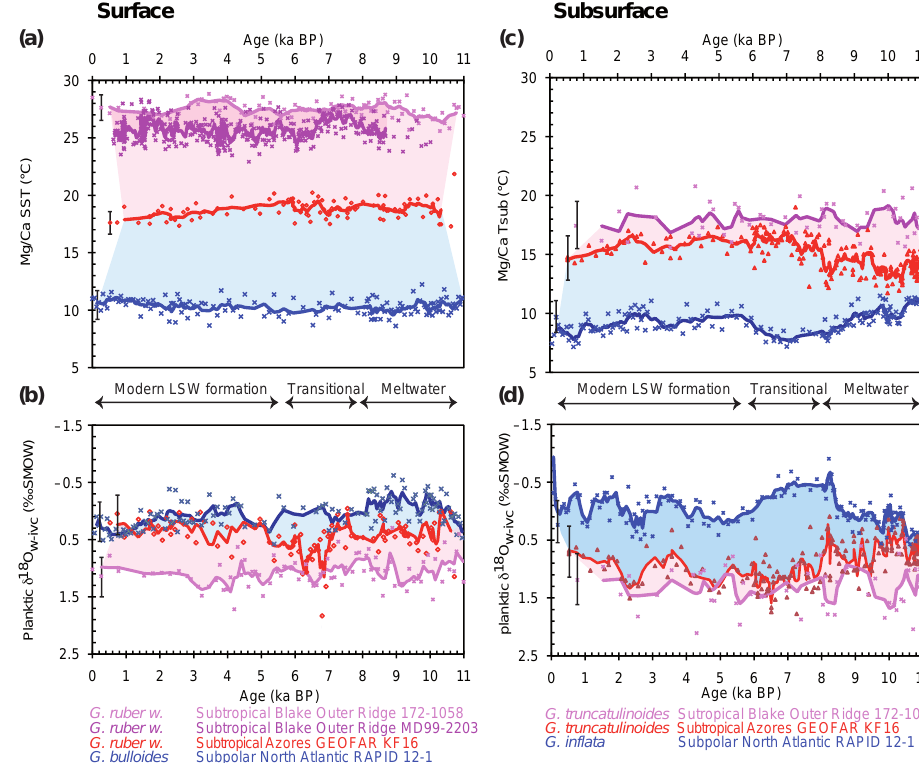
Figure 3. Surface and subsurface temperature and salinity reconstructions from the tropical to subpolar North Atlantic. Left panels show a comparison between (a) surface temperatures and (b) δ 18 O w-ivc records from the tropical (pink) (Bahr et al., 2013), subtropical (red), and subpolar (blue) (Thornalley et al., 2009) North Atlantic. Right panels show a comparison between (c) subsurface temperatures and (d) δ 18 O w-ivc records from the tropical (pink) (Bahr et al., 2013), subtropical (red), and subpolar (blue) (Thornalley et al., 2009) North Atlantic. Grey bars indicate the SD for all